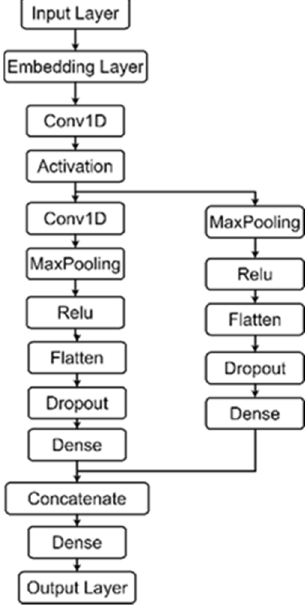
Figure 5. Hierarchy of the SPCNN.